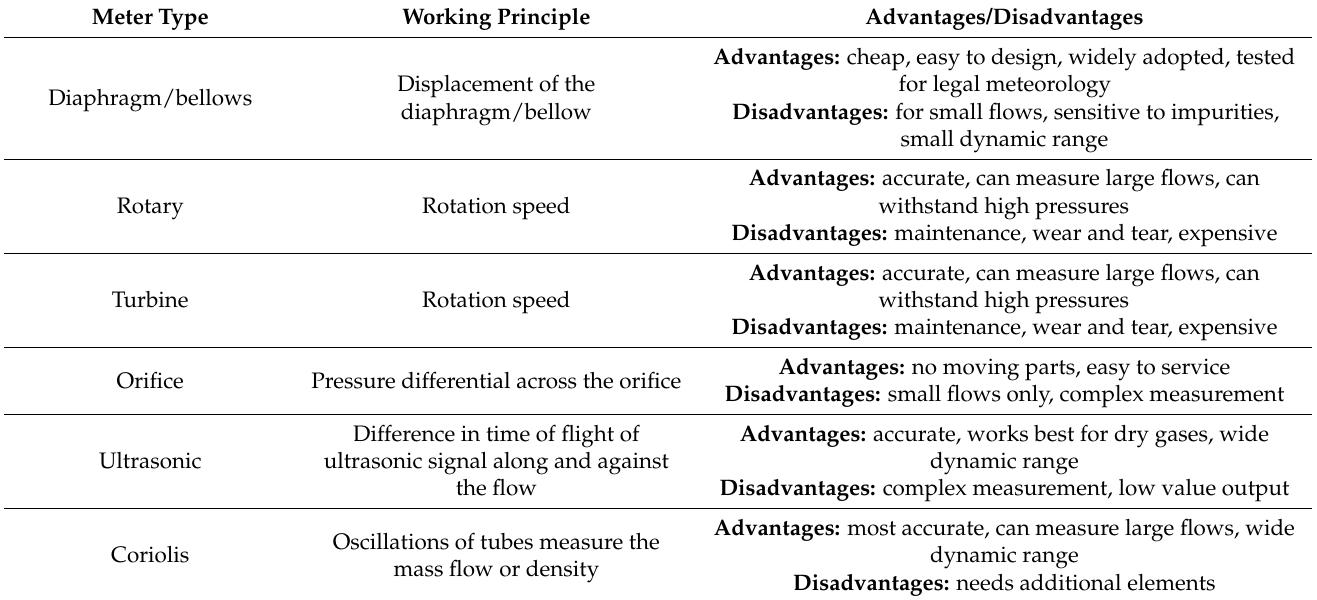
Table 3. Different types of gas